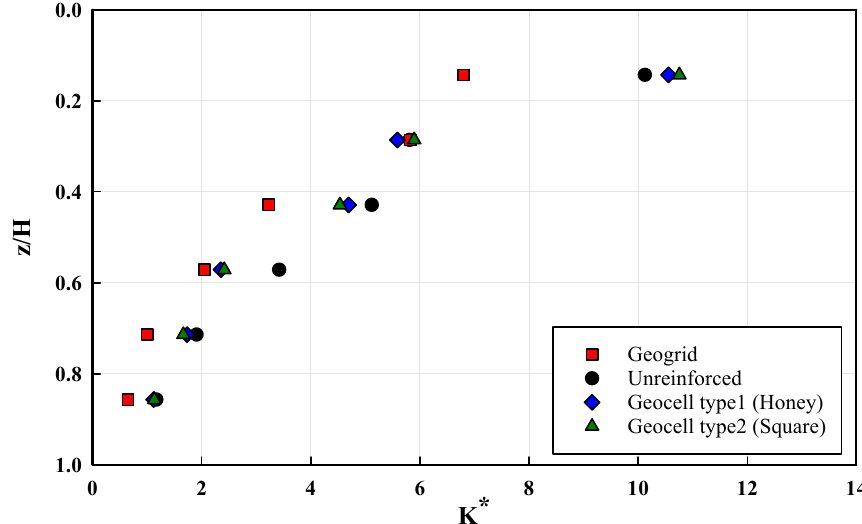
(cid:3049)(cid:2868) at each height. As shown in Figure 14,